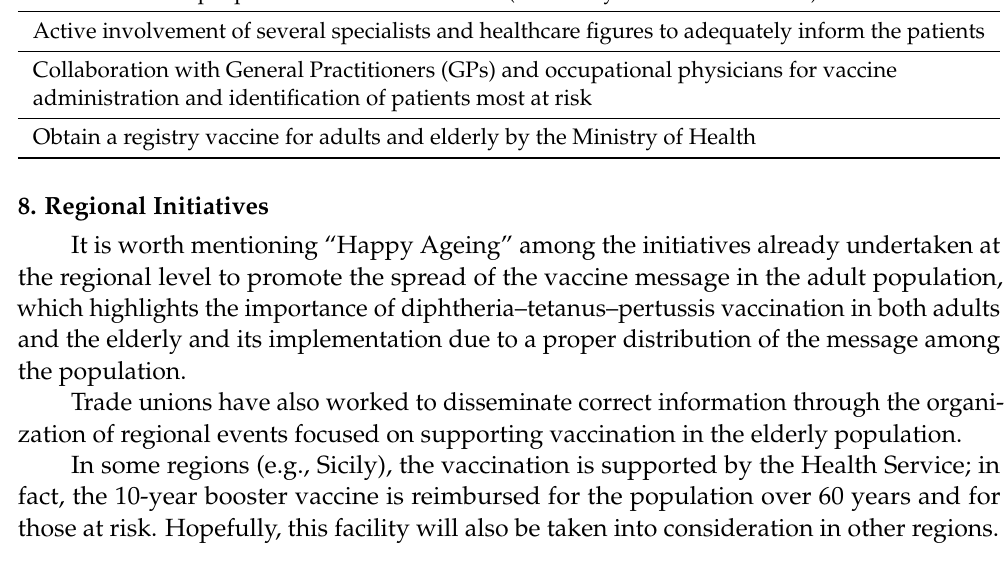
Table 4. Summing-up of the strategies to improve the vaccination between adults and elderly. Vaccination habit: vaccination pathway throughout all ages Active call to all people suitable for vaccination (invited by vaccination centers) Active involvement of several specialists and healthcare figures to adequately inform the patients Collaboration with General Practitioners (GPs) and occupational physicians for vaccine administration and identification of patients most at